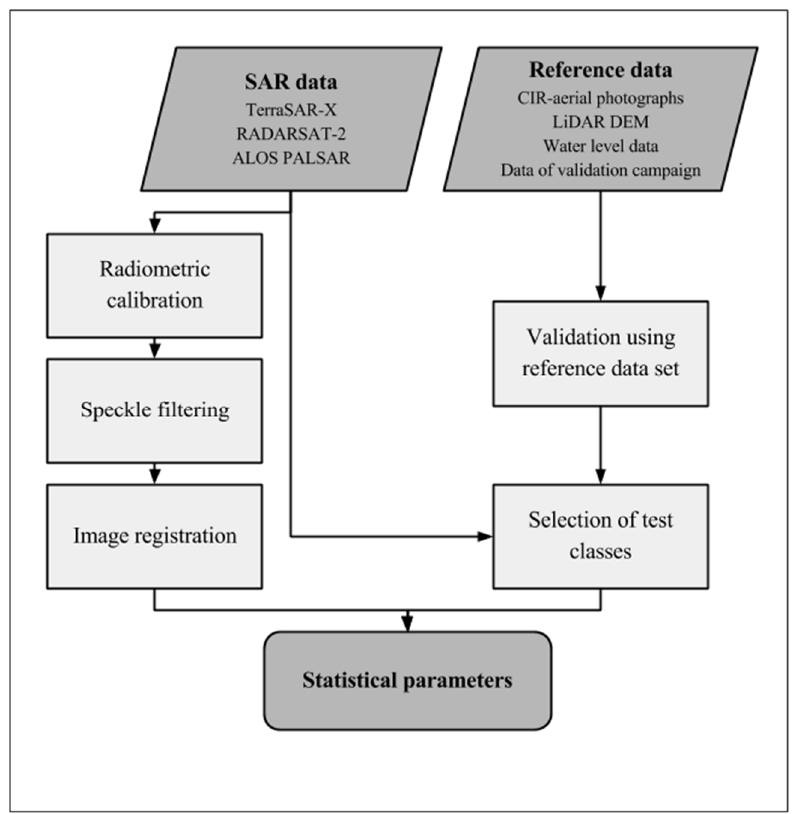
Figure 3. Workflow for time-series